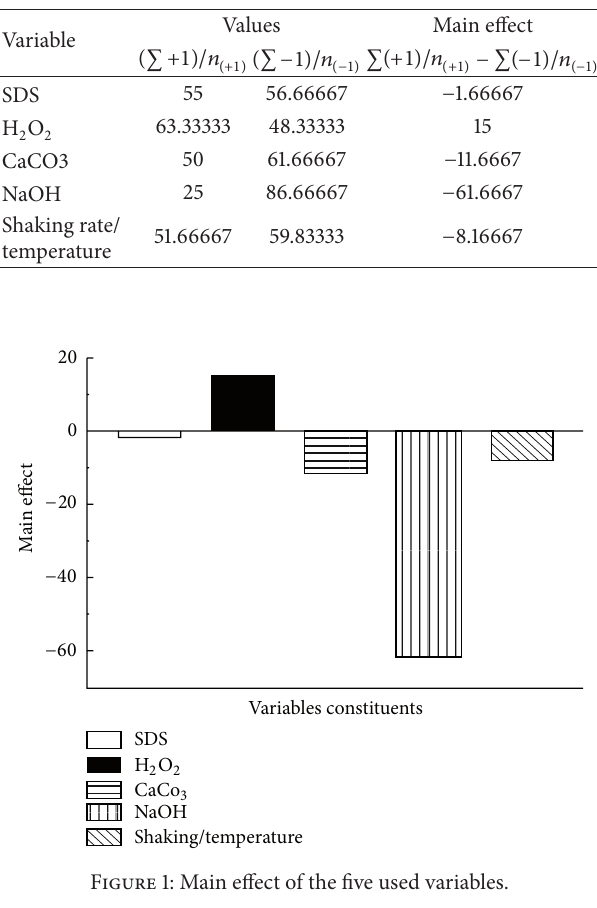
Figure 1: Main effect of the five used